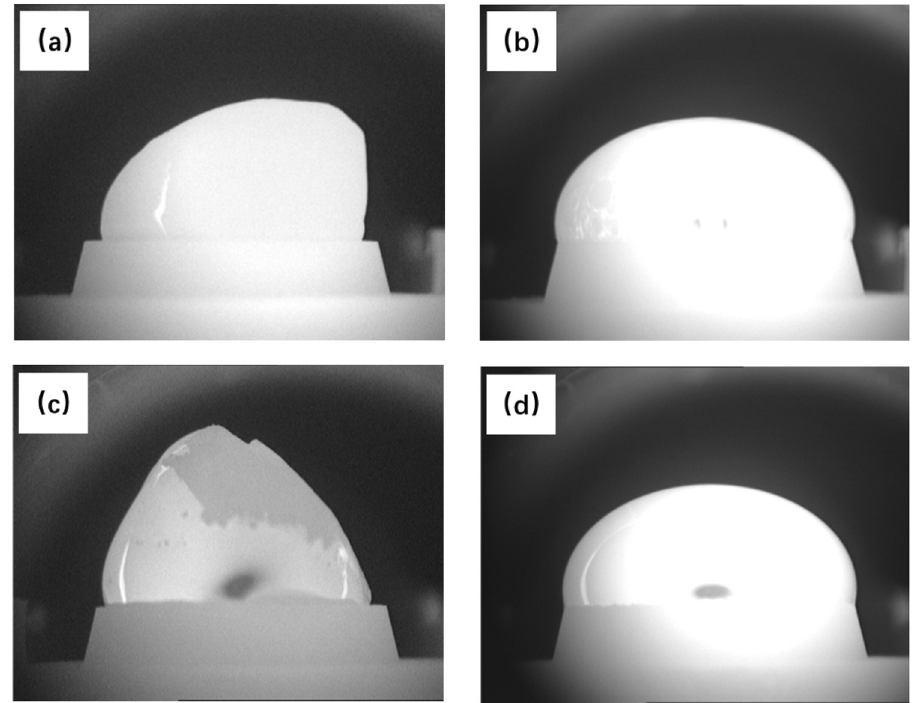
Figure 1: Photos of a droplet of sample A at temperatures of ( a ) 1,460°C and ( b ) 1,750°C and that of a droplet of sample B at temperatures of ( c ) 1,450 and ( d ) 1,750°C.